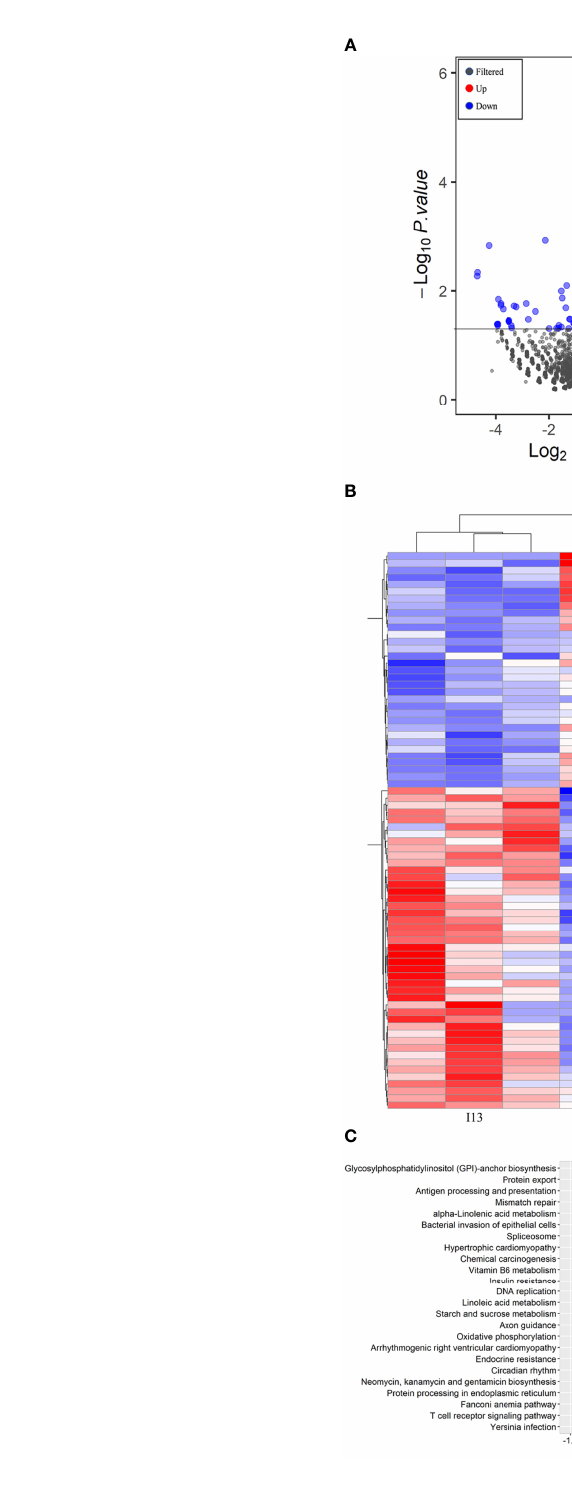
FIGURE 6 | The cell differentiation effect of I13 is associated with antigen-processing and presentation-signaling pathways in Kasumi-1 cells. (A) Volcano plots of Kasumi-1 cells. (B) Heatmap of differentially expressed genes (p < 0.05 andlog2FC| > 0.58) according to their p-value. (C) The enriched pathways of differentially expressed genes using GSVA analysis. Kasumi-1 cells were incubated with 0.5 µM I13 for 48 h, and then mRNA sequencing was performed. The fi gures are representative of three independent